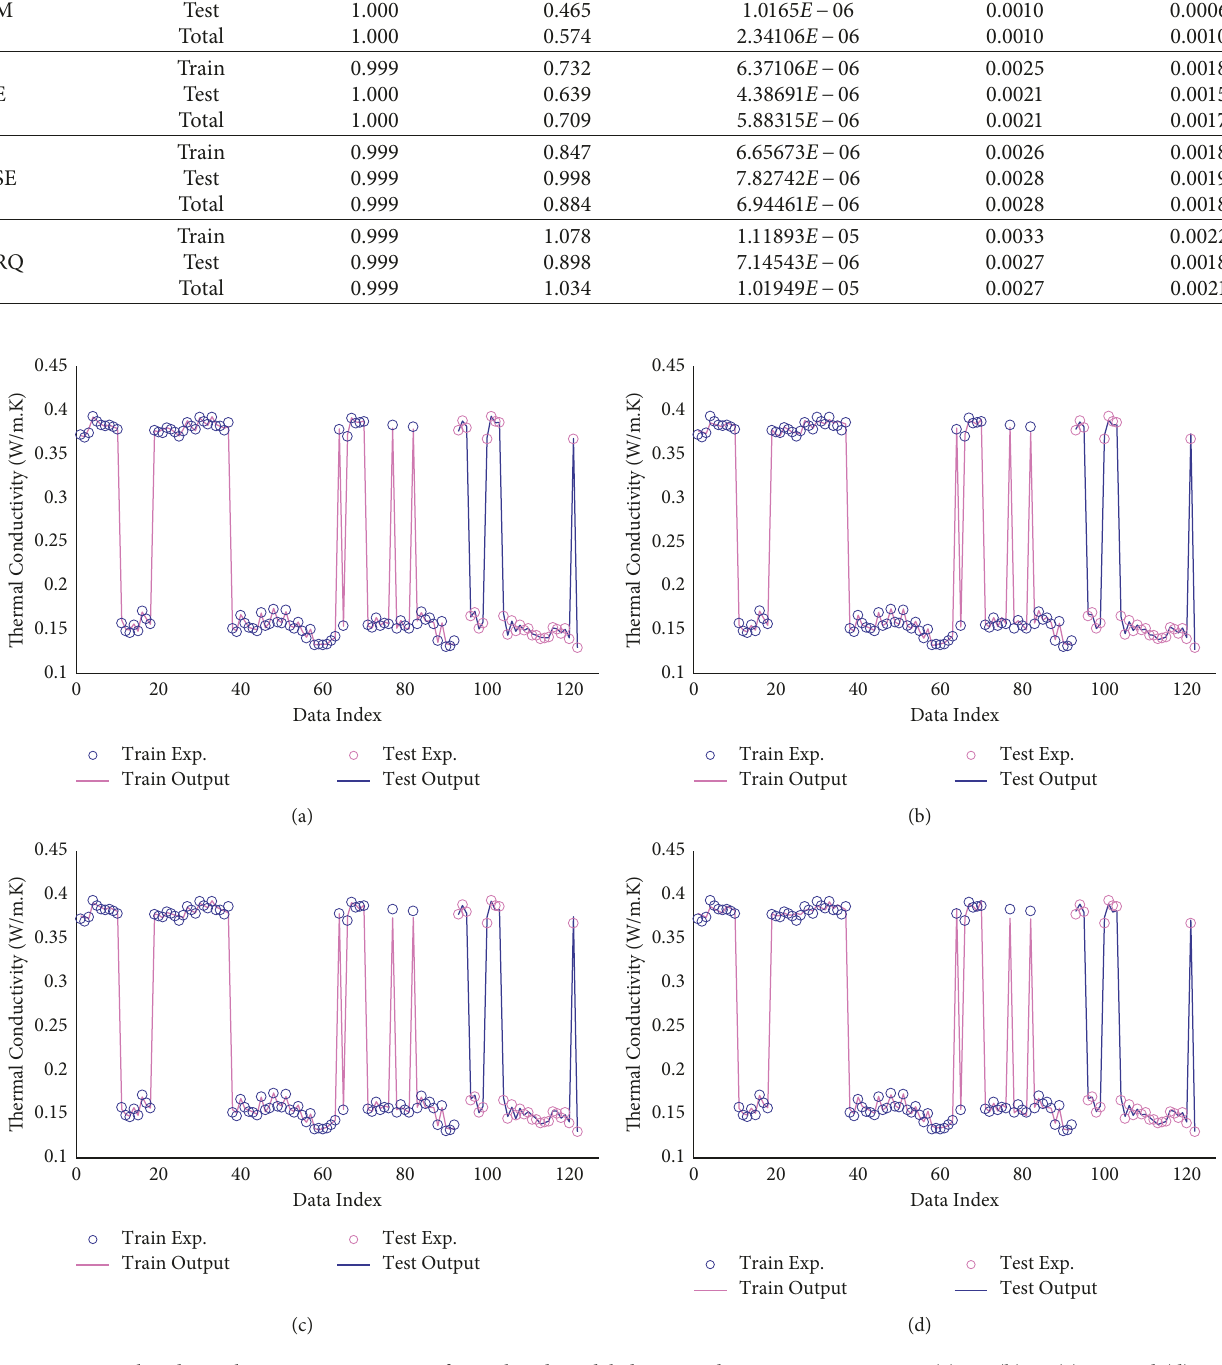
Figure 3: Visual and simultaneous comparison of actual and modeled output data using various KFs: (a) M, (b) E, (c) SE, and (d)